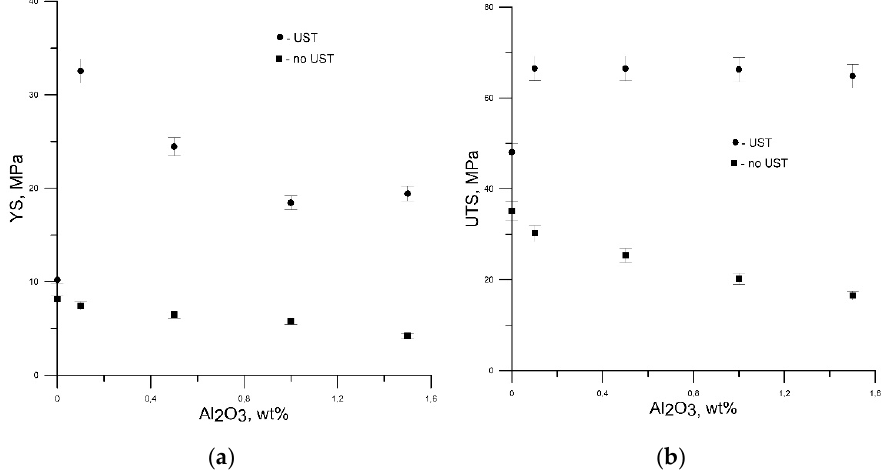
Table 1. Mechanical properties of the investigated alloys.